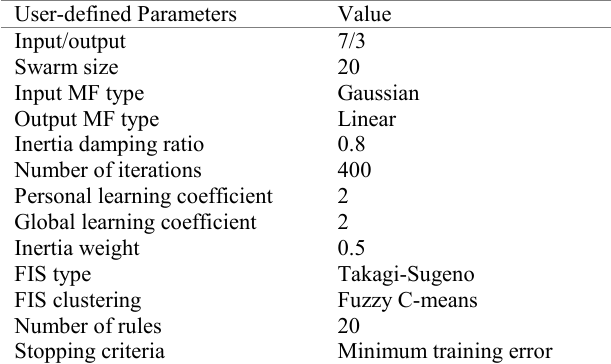
Table 3. The specification of the PSO learning